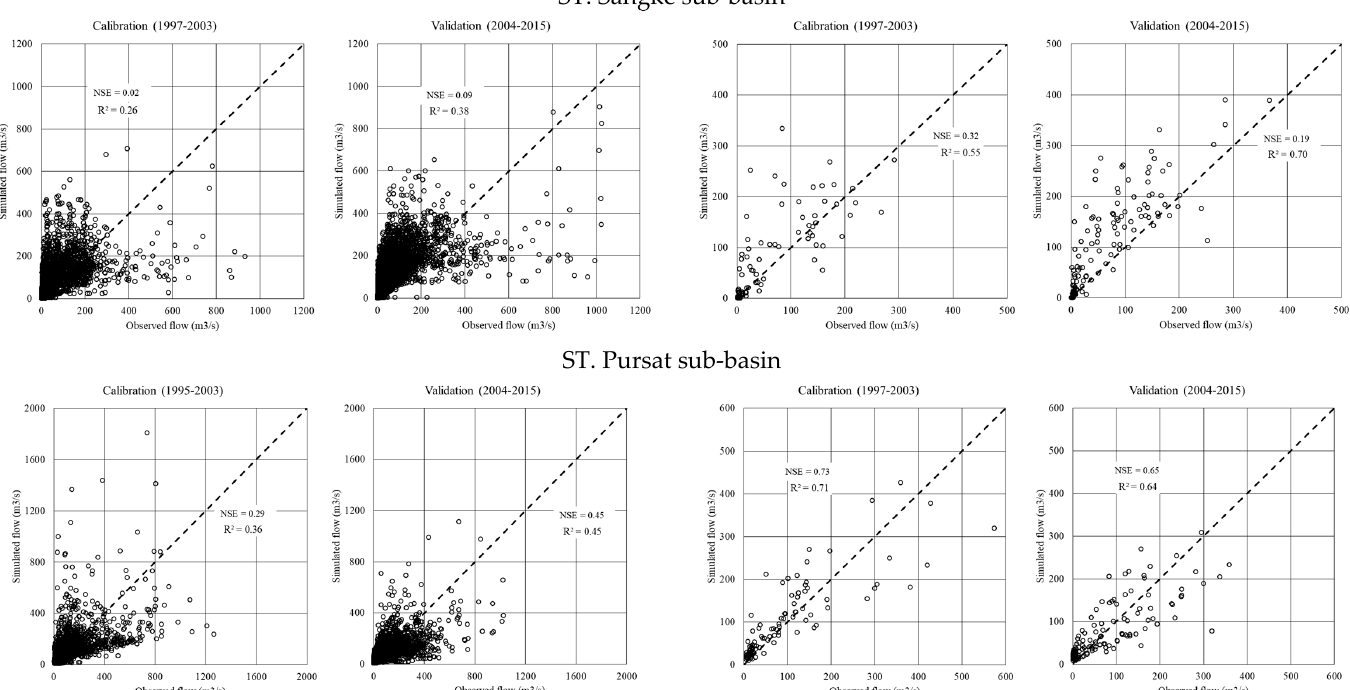
Figure A1. Scatter plots comparing between the observed and simulated river flows in selected sub-basins (ST. Sen, ST. Sangke, ST. Pursat) during calibration and validation.